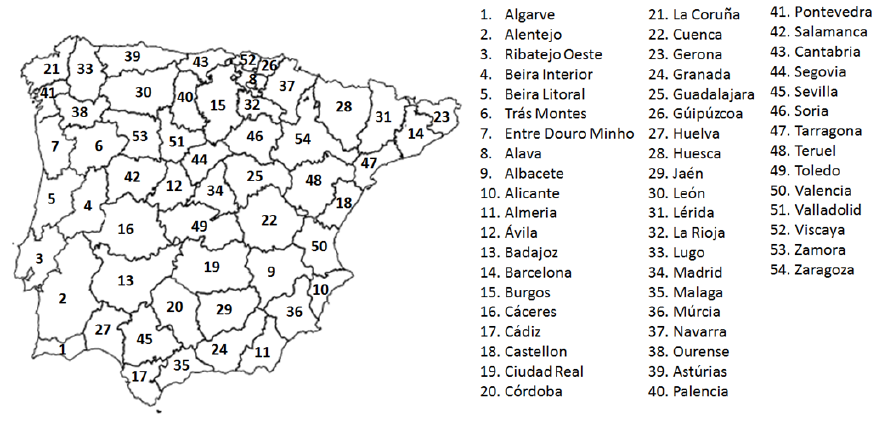
Figure 1. Geographical boundaries of the fifty-four regions of the Iberian Peninsula.